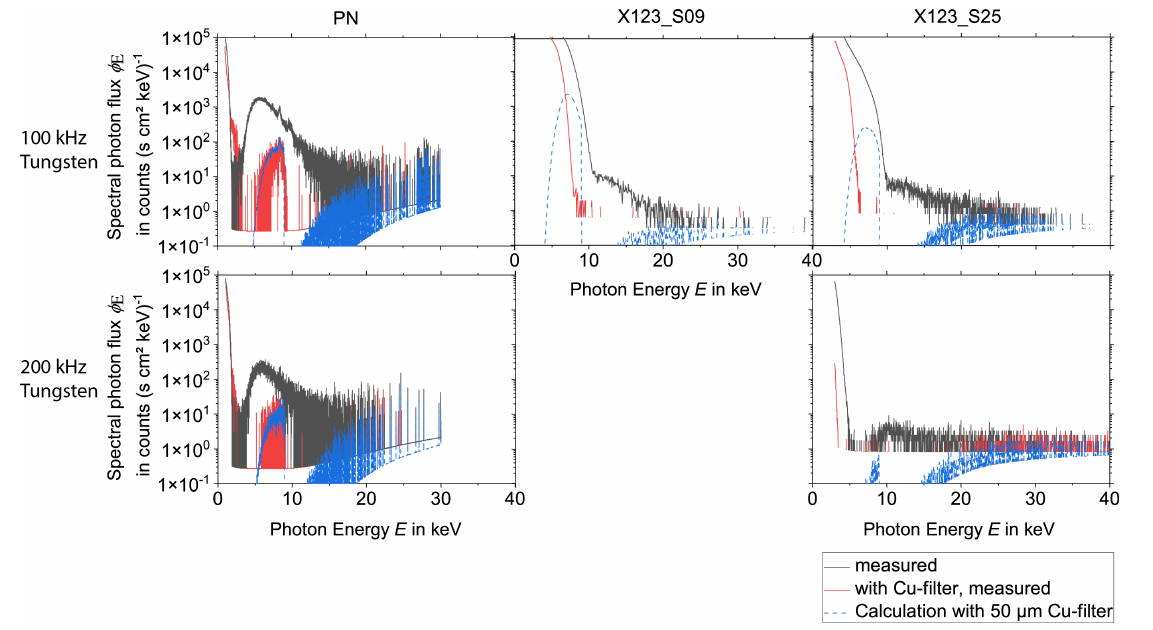
Figure 4. X-ray spectra measured during the laser processing of tungsten without burst mode for the three spectrometers PN, X123_S09, and X123_S25, the measurement with and without Cu-filter was compared with the calculation with copper filter of 50 µ m thickness. Note the logarithmic scaling of the ordinate axes.